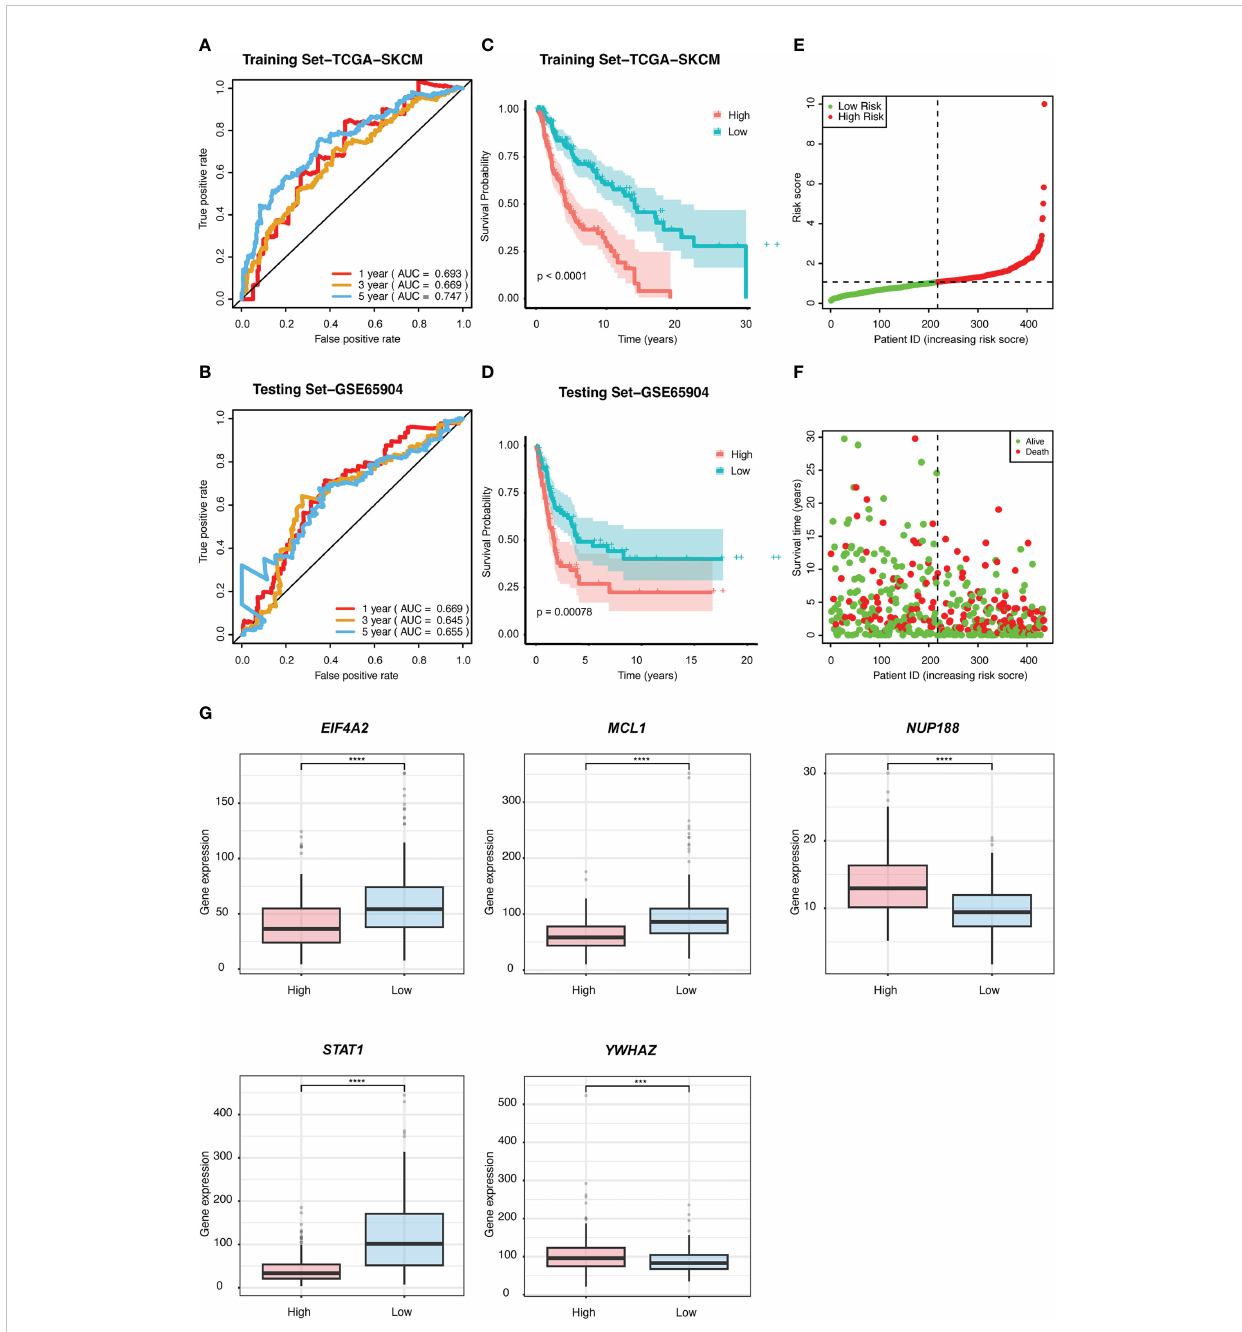
FIGURE 4 The prognostic value of the risk signature was validated. ROC curves for predicting 1-, 3-, and 5-year overall survival (OS) in the (A) TCGA and (B) GSE65904 datasets using the risk model. Kaplan − Meier curves were used to assess the OS probabilities in the training (C) and testing groups (D) . (E) In the training dataset of TCGA, the risk score (RS) of each patient is displayed. (F) OS and survival status are shown in the TCGA cohort (red dots indicate death, and green dots indicate survival). (G) The expression of the fi ve CSIRGs ( EIF4A2 , MCL1 , NUP188 , STAT1 , and YWHAZ ) used to construct the prediction model was analyzed in the high- and low-risk groups. : ***: P ≤ 0.001 and ****: P ≤